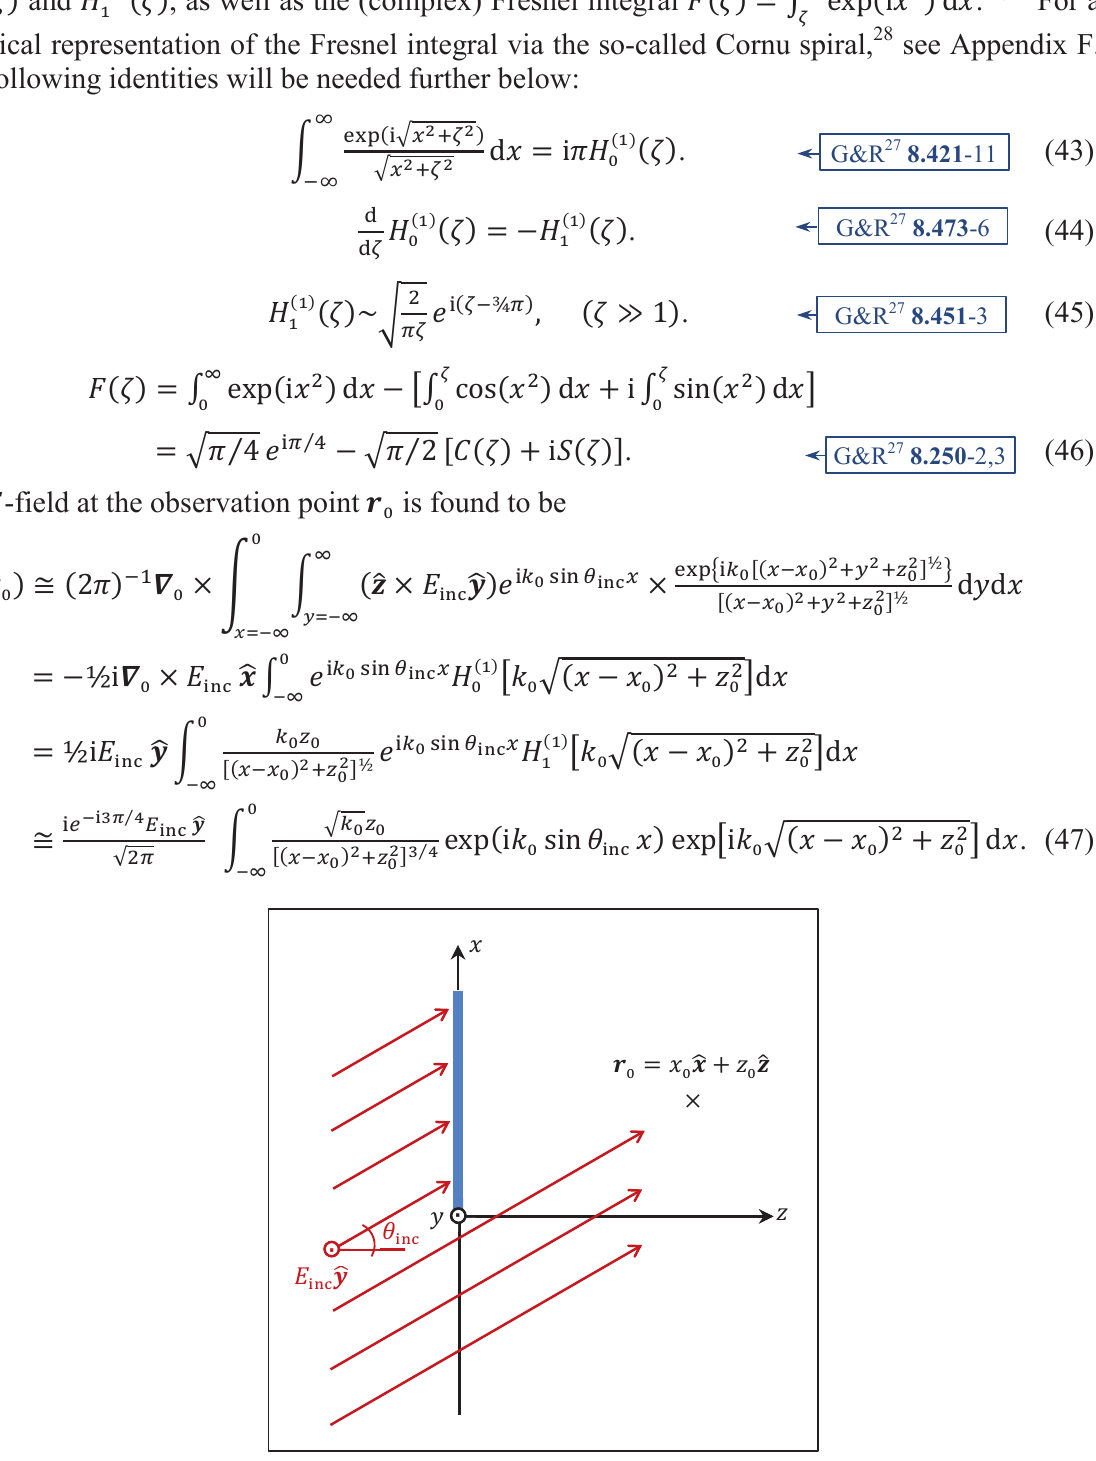
, frequency (cid:2033) , wave-number (cid:1863) = (cid:2033) (cid:1855)(cid:932) , (cid:3167)(cid:3172)(cid:3161) (cid:3116) is in the (cid:1876)(cid:1878) = sin (cid:2016) (cid:2206)(cid:3549) + cos (cid:2016) (cid:2208)(cid:3548) . The observation point (cid:2200) (cid:3167)(cid:3172)(cid:3161) (cid:3167)(cid:3172)(cid:3161) (cid:3167)(cid:3172)(cid:3161) (cid:3116)